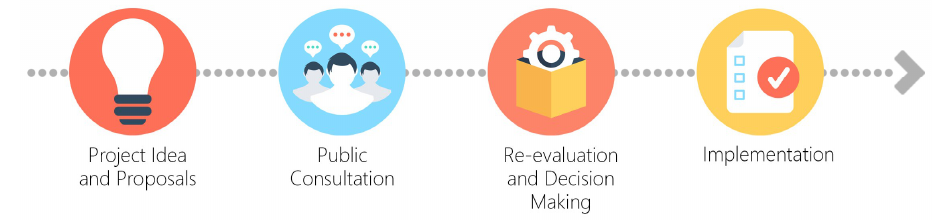
Figure 1. Current model of participation in Urban Planning process.